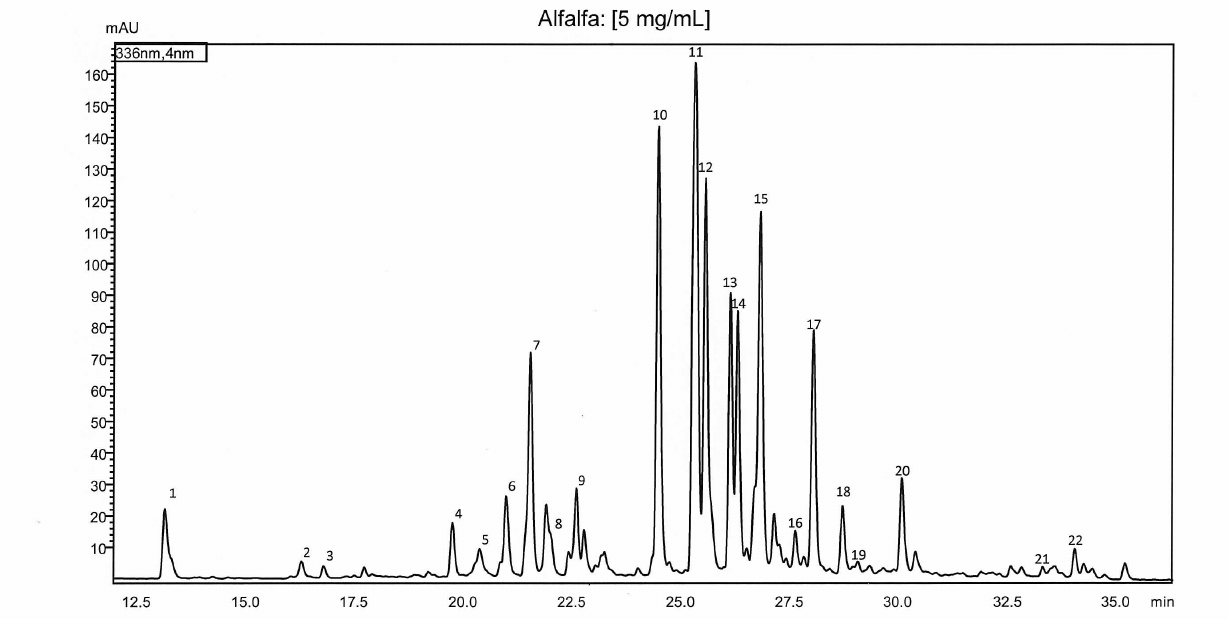
Figure 1. Liquid chromatography coupled with photodiode array profile at 336 nm of alfalfa